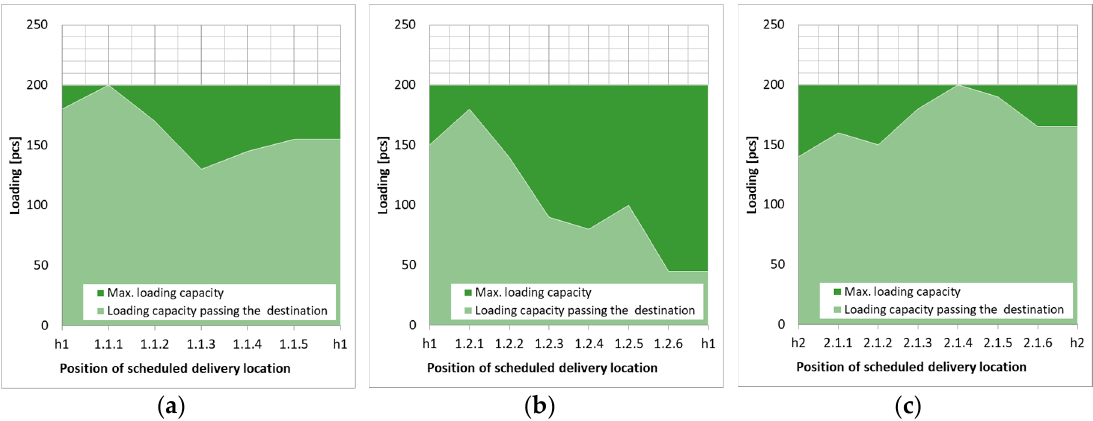
Figure 11. Loading of delivery trucks with scheduled deliveries. The initial loadings are the loading volumes in the h1 and h2 hubs: 170 pcs, 150 pcs, and 140 pcs. ( a ) Loading of delivery truck assigned to route 1; ( b ) Loading of delivery truck assigned to route 2; ( c ) Loading of delivery truck assigned to route 3.